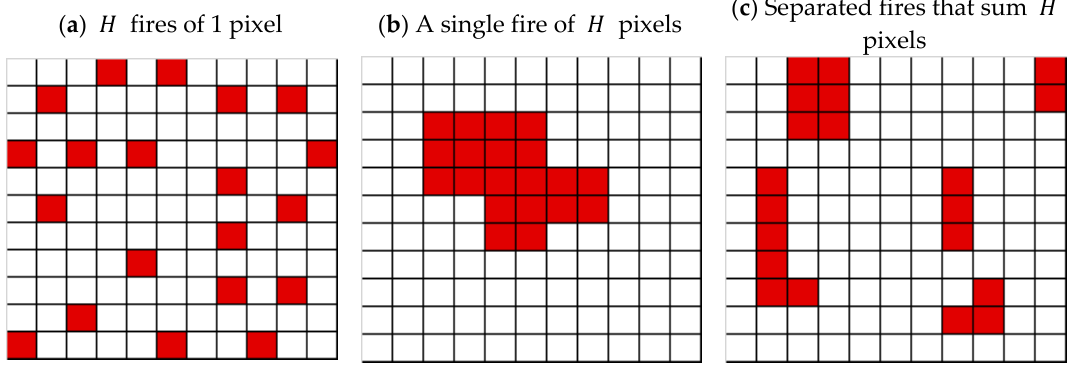
Figure 1. Different fire morphologies can provide the same error matrix. Reports of products with ( a ) area burned of - H fires- of 1 pixel, versus—( b ) A single fire- of H pixels, or ( c ) separated fires that sum H pixels.